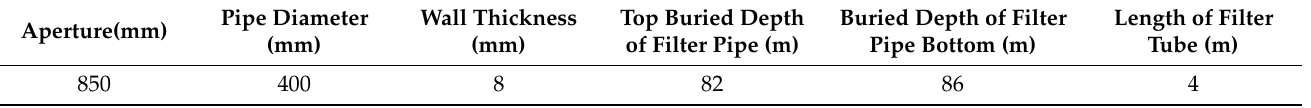
Table 3. Structure information of injection well.